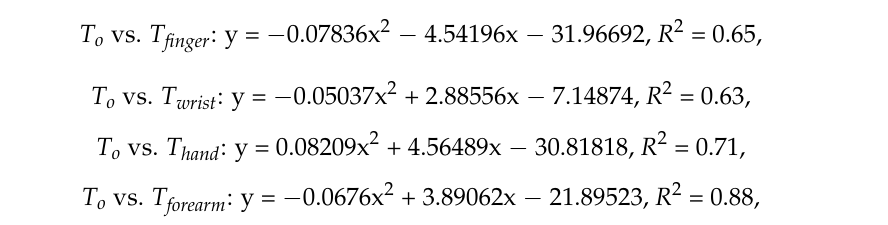
Table 5. Mean upper extremity skin temperatures of investigated occupants. TS 33.7 ± 0.9 Note: Data is presented as mean ± SD. M = men, F = women; All, All occupants; T finger , Finger skin temperature; T forearm , Forearm skin temperature; T wrist , Wrist skin temperature; T hand , Hand skin temperature; * p < 0.05, difference between women and men; *** p < 0.001, difference between women and men.